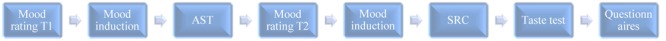
An overview of the experiment.